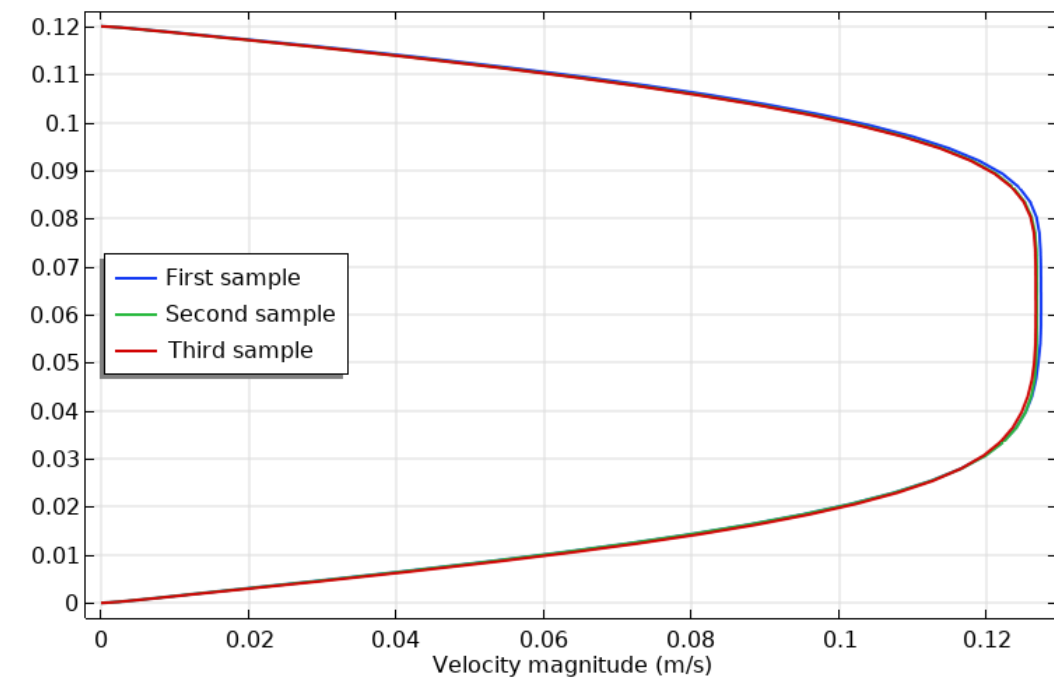
Figure 18. Velocity profile in the outlet passage flow .